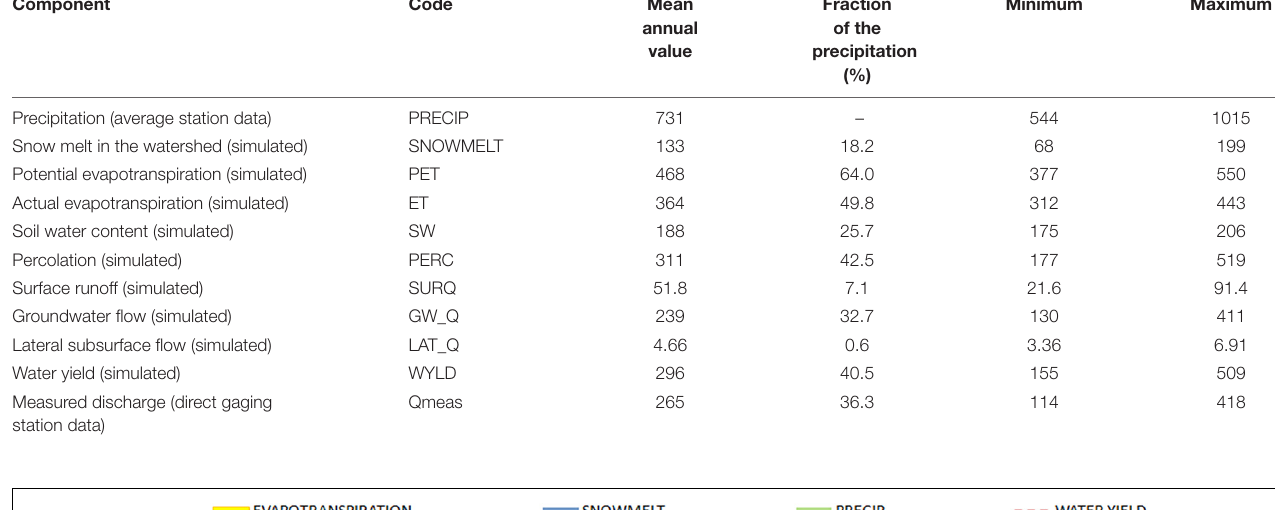
Fraction Minimum Maximum of the value precipitation (%)